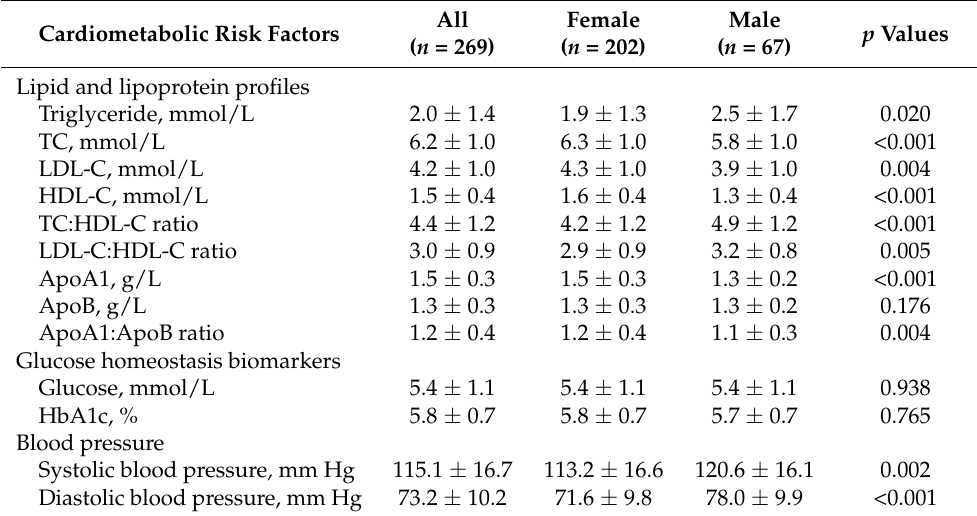
Table 2. Cardiometabolic risk factor levels of 269 Chinese participants with hyperlipidemia according to gender 1,2 .